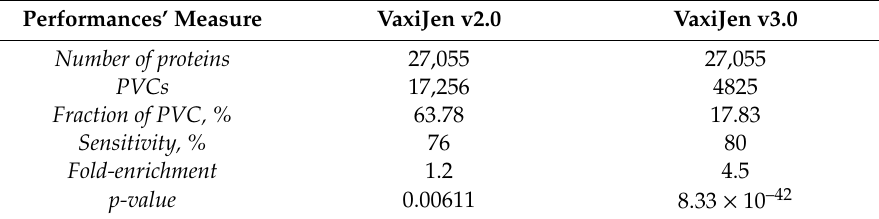
Table 2. Performance measures for VaxiJen v2.0 and VaxiJen v3.0.